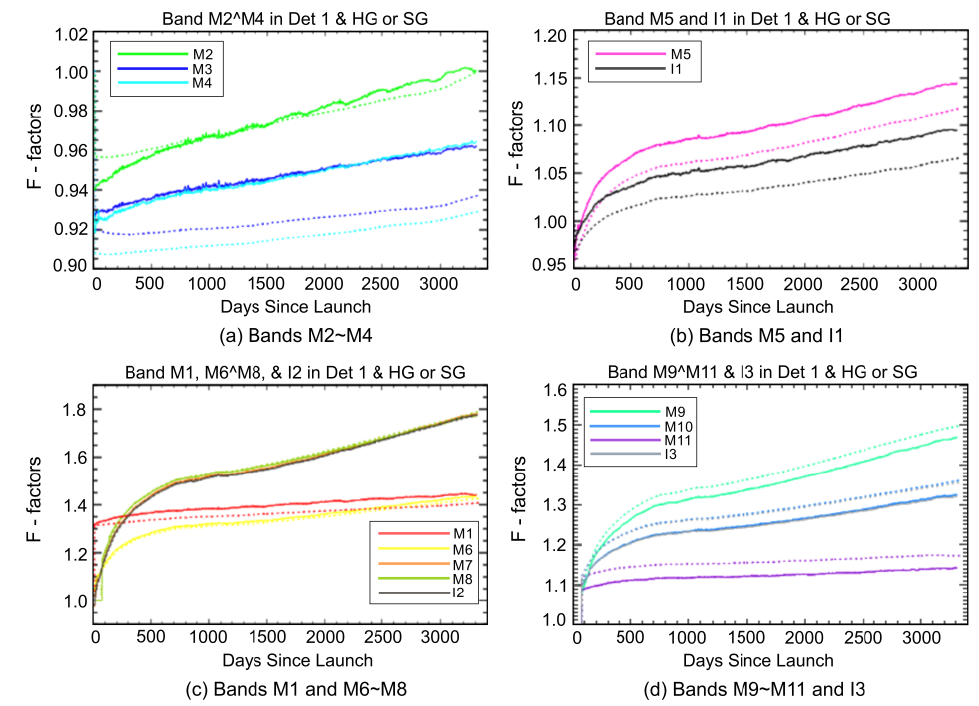
Figure 14. F-factor comparison plots between NASA F-factors (solid lines) and NOAA version 2 F-factors (dotted lines) in the RSB